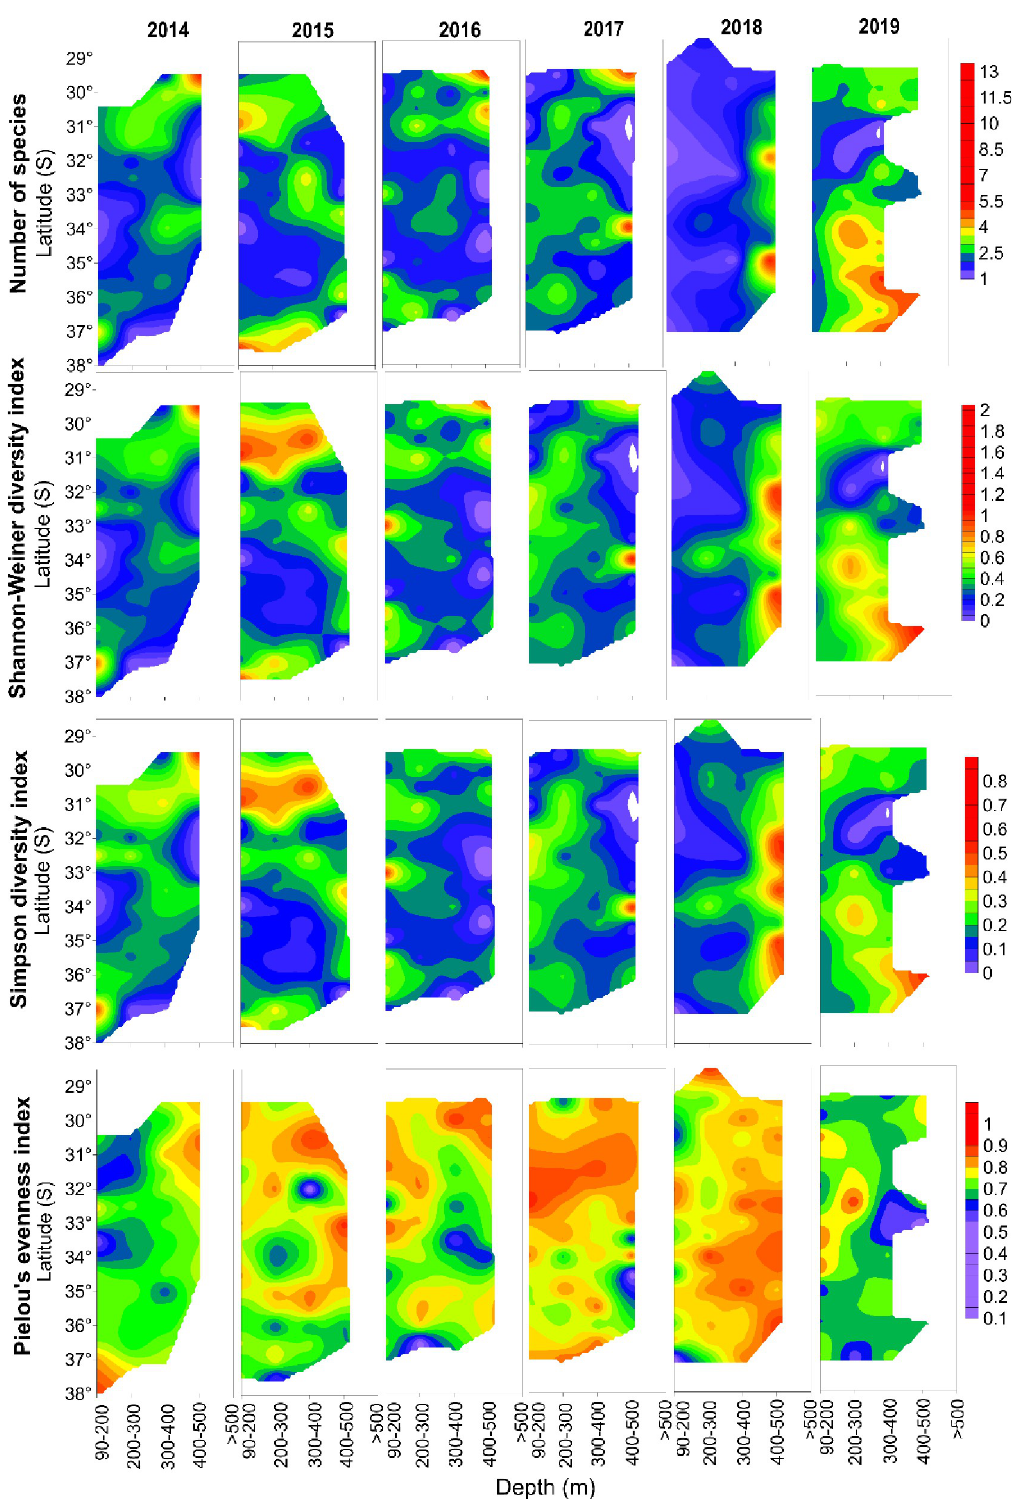
Fig 5. Spatial variability (in latitude and depth) of alpha-biodiversity indices of the discarded demersal community off central Chile between 2014–2019.